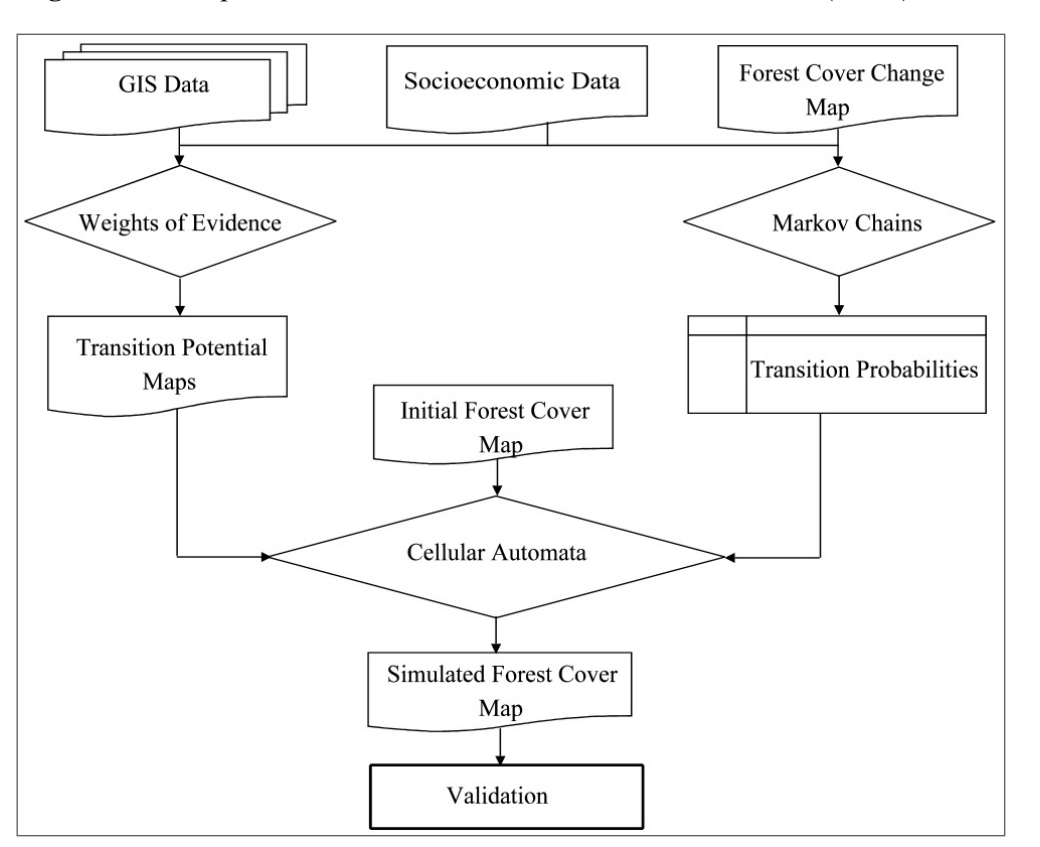
Figure 3. Conceptual framework of the Markov-cellular automata (MCA)